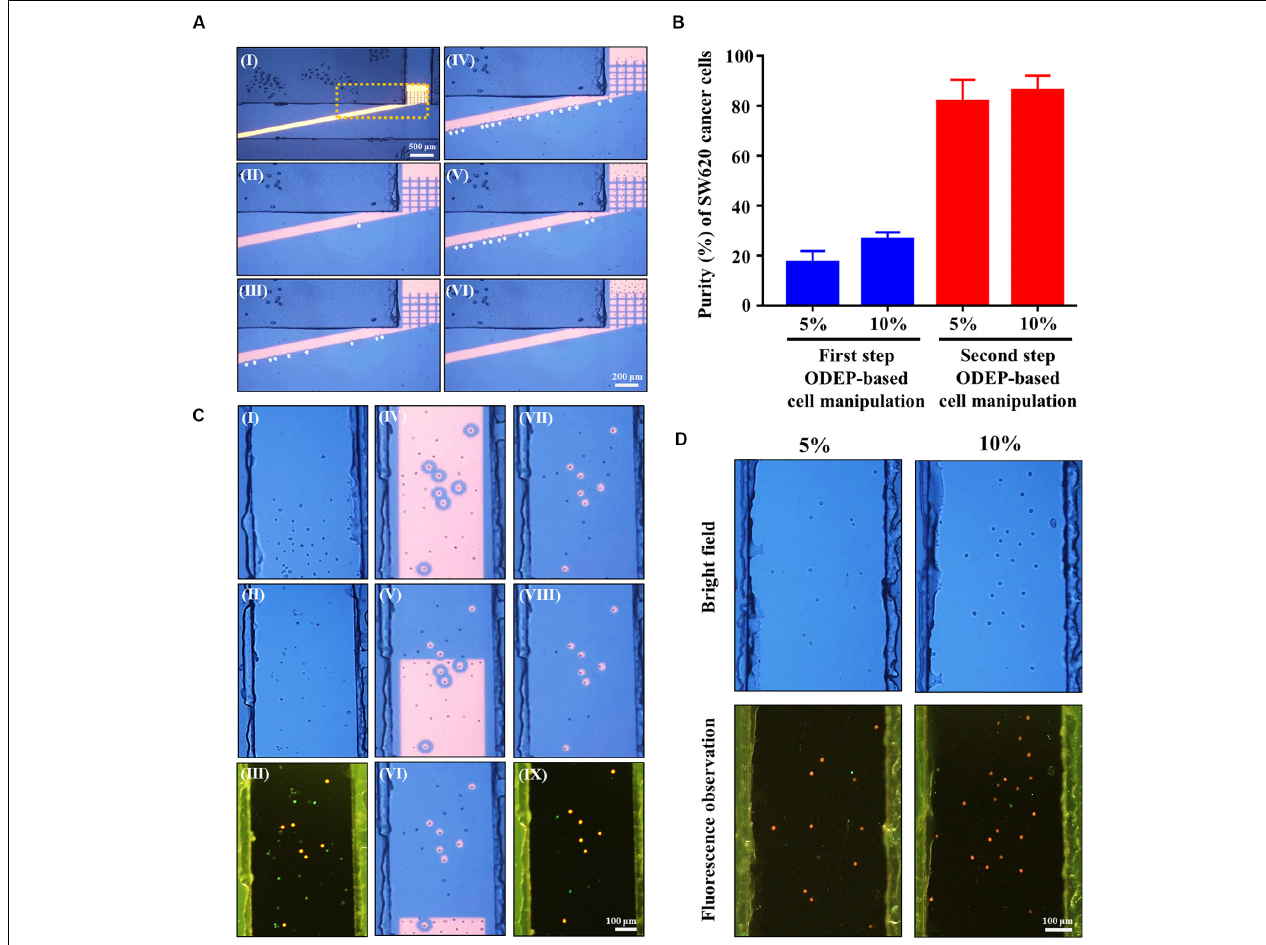
FIGURE 5 | (A) microscopic observations of the first-step ODEP cell manipulation process; (I) a static rectangular light bar (L: 3.9 mm, W: 100 µ m) with a particular angle (e.g., 15 ◦ ) to the flow direction of the cell suspension was designed in the main microchannel, (II–VI) the SW620 cancer cells (indicated by arrows) were sorted, separated, and then guided along the rectangular light bar image to the side microchannel for collection (a video clip is provided as Supplementary Videos 1 , 2 ), (B) the purity (%) of SW620 cancer cells obtained after the first and second step ODEP cell manipulation processes for the prepared cell samples originally containing 5 and 10% SW620 cancer cells, respectively, (C) microscopic observations of the second-step ODEP cell manipulation process; (I) a certain amount of the cancer cells were collected in the side microchannel, (II) the liquid flow in the side microchannel was driven to flux the cells collected so that they were evenly spread within the side microchannel, (III) fluorescence microscopy observation was carried out to identify the species of the cells [i.e., fluorescence stained SW620 cancer cells (the red dots) and immunofluorescence stained magnetic microbead-bound Jurkat cells (the green dots)] collected in the side microchannel for positioning the SW620 cancer cells, (IV) static circular light images were illuminated on each SW620 cancer cell. Meanwhile, the side microchannel was illuminated with a rectangular light bar to manipulate the magnetic microbead-bound Jurkat cells into the side microchannel, in which O-ring-like non-illuminated patterns were designed as partitions to separate the light-illuminated SW620 cancer cells and the other cells, (V–VII) the rectangular light bar on the side microchannel was then moved to manipulate the magnetic microbead-bound Jurkat cells to remove them from the side microchannel, and this process was repeated for 5 times, (VII–IX) through the previous process, the cell purity of the SW620 cancer cells in the side microchannel was greatly improved (a video clip is provided as Supplementary Video 3 ), (D) microscopy observation of the cells collected in the side microchannel after two-step ODEP manipulation processes for the prepared cell samples originally containing 5 and 10% SW620 cancer cells, respectively (Bright field: the upper row, Fluorescence observation: the lower row, SW620 cancer cells: the red dots; 50 nm magnetic microbead-bound Jurkat cells: the green